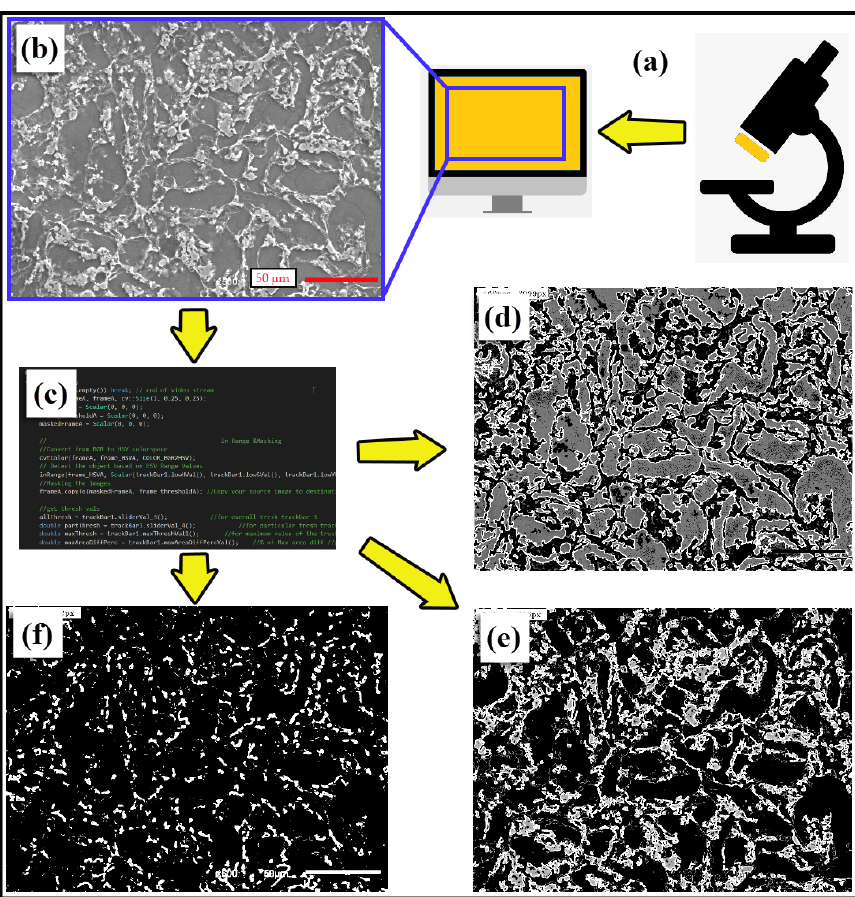
Figure 1. Manual grain counting method: ( a ) original SEM image of sample 1, ( b ) measuring by horizontal, ( c ) measuring by vertical.